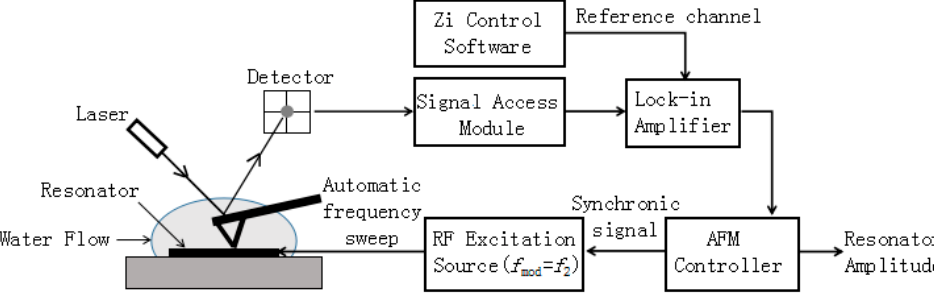
Figure 2. Automatic and fast experimental detection setup for contact/tapping mode of atomic force microscopy used in this work.